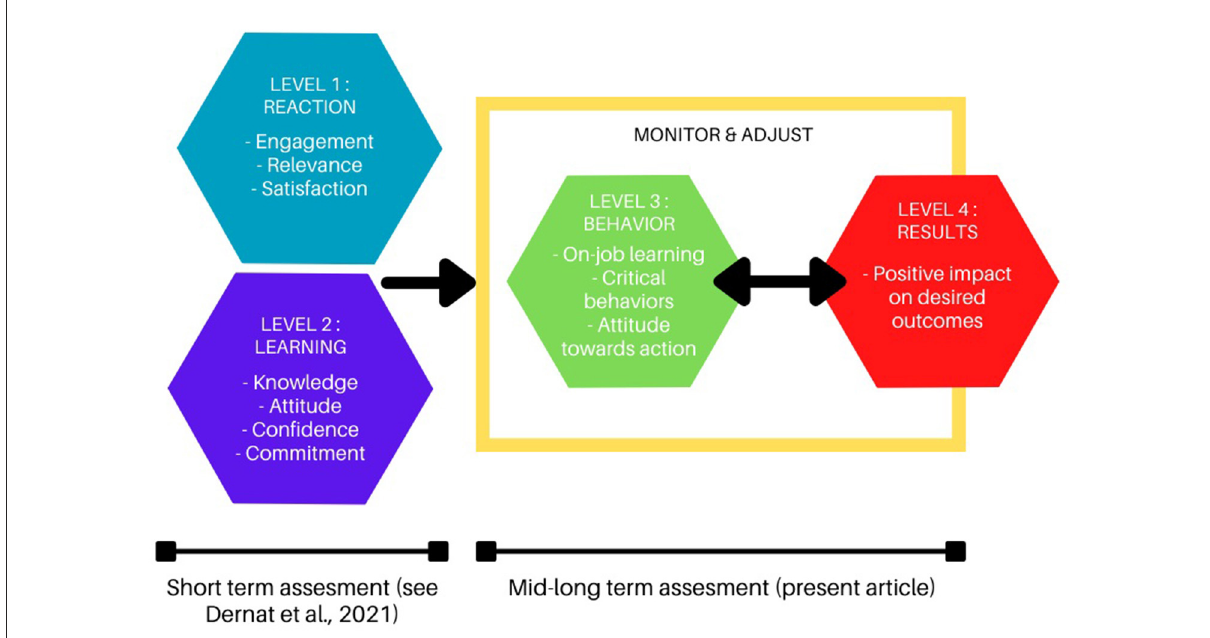
FIGURE2 New World Kirkpatrick Model (NWKM from Kirkpatrick and Kirkpatrick, 2016).